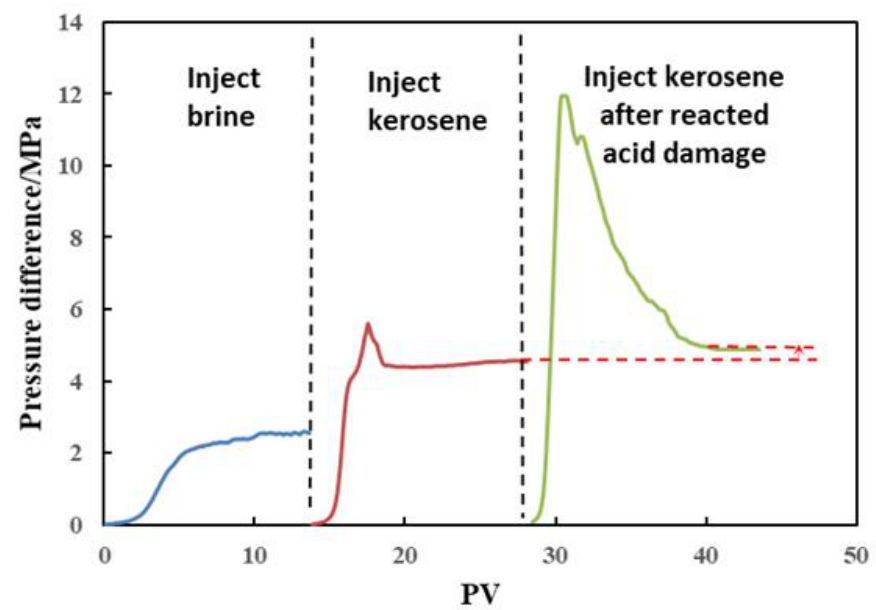
Figure 15. Core permeability in different treatment stages.